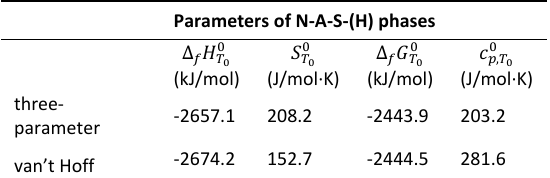
Table 3. Thermodynamic parameters of crystalline N ‐ A ‐ S ‐ (H) calculated from three ‐ parameter Gibbs free energy model and van’t Hoff